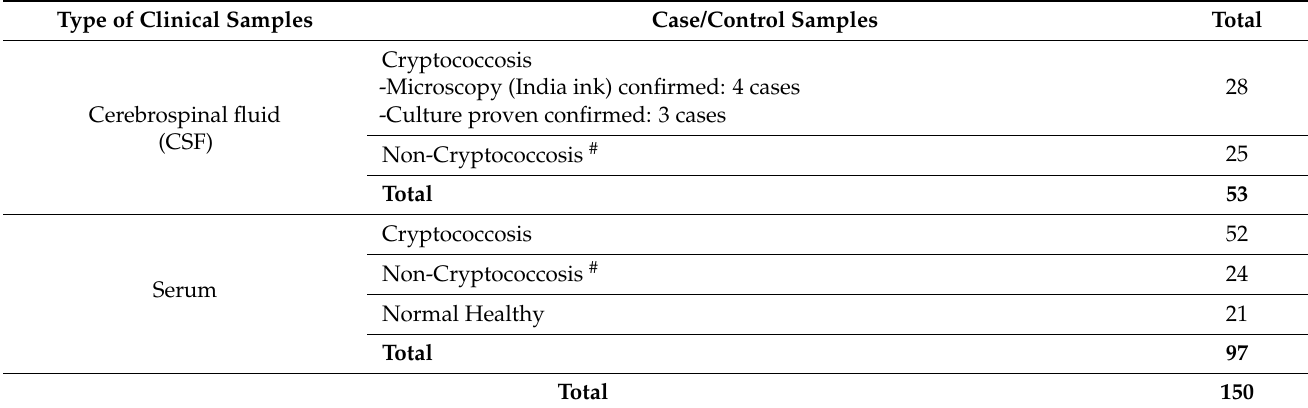
Table 2. Clinical samples from patients with or without cryptococcosis. Type of Clinical